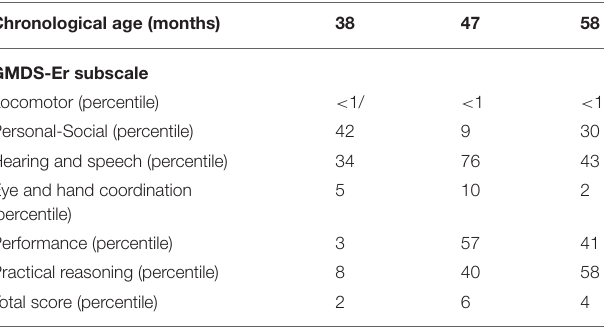
TABLE 2 | Griffiths mental development scales-extended revise from the treated